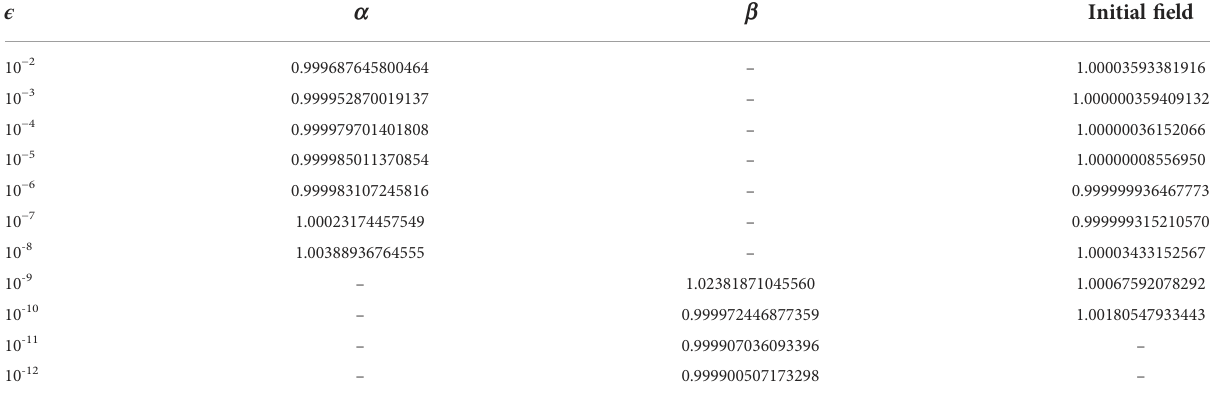
TABLE 2 The correctness test of the gradient of the cost function with respect to a , b , and initial fi